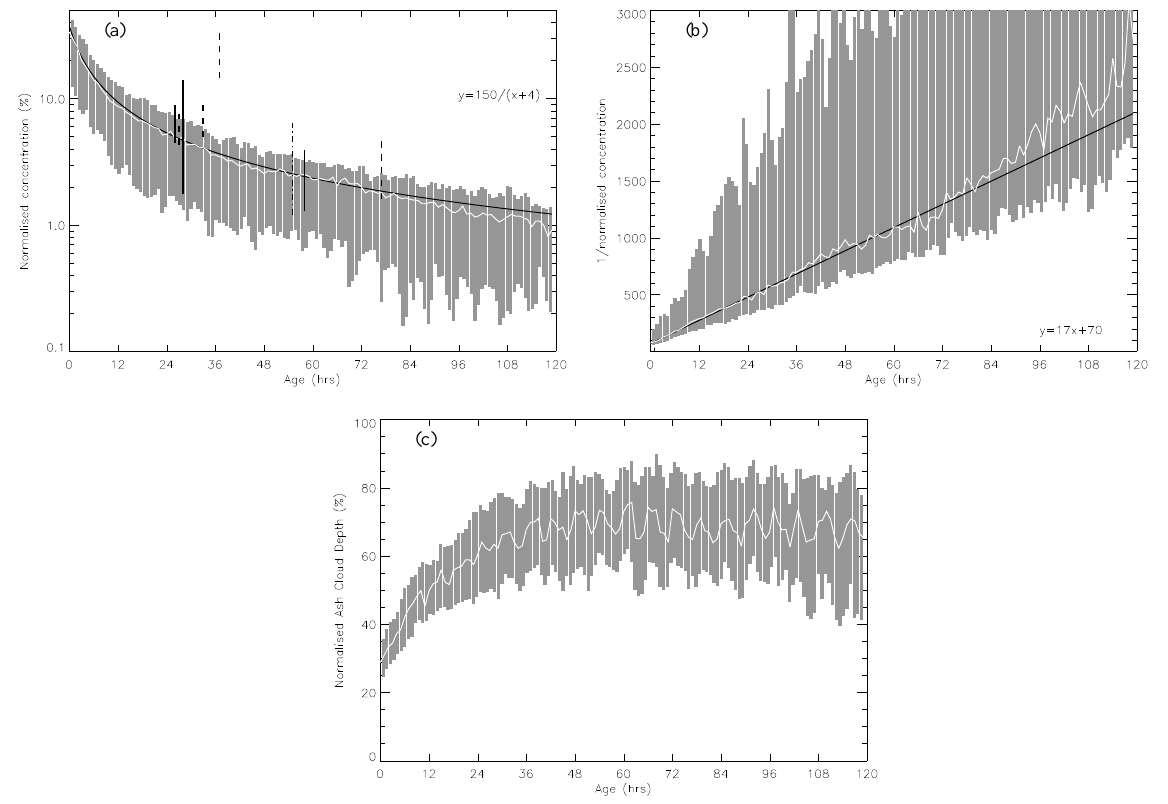
Fig. 9. Mean (solid white line) and 25–75th percentile (grey shading) of (a) NAME normalised concentration overlaid with observed nor- malised concentration as a function of travel time (in-situ measurements (solid), lidar measurements (dashed, dash-dot), fit to mean (solid black line and equation)), (b) 1/normalised concentration as a function of travel time (fit to mean (solid black line and equation)), and (c) normalised ash cloud depth as a function of travel time.